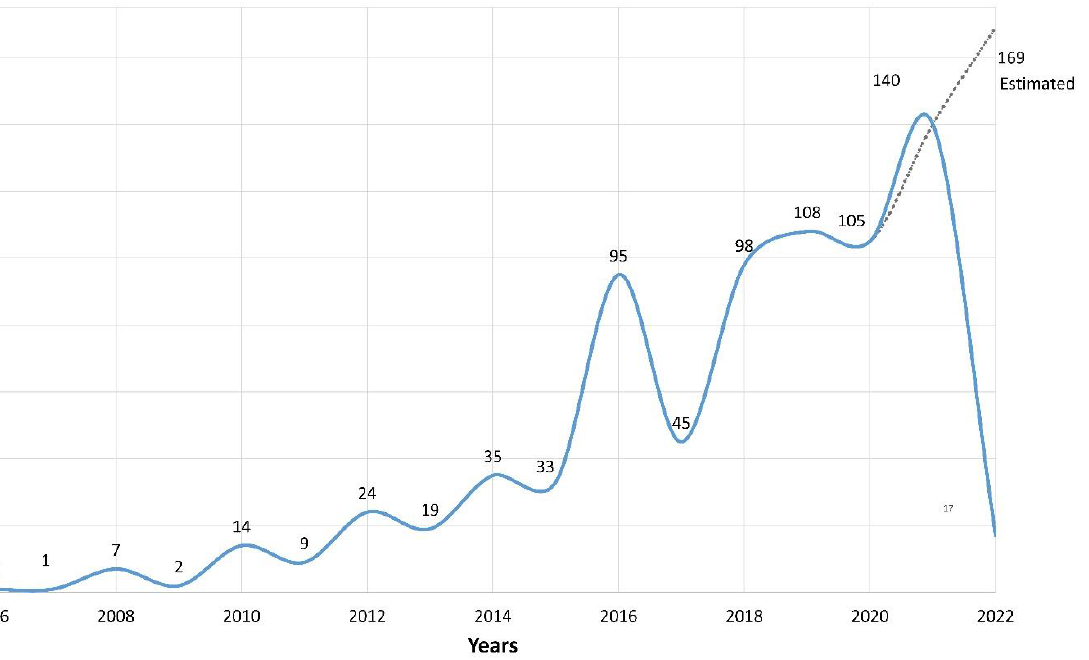
Figure 2. Historical trend of published studies in cross-laminated timber (CLT) for construction (period 2006 – 2022).